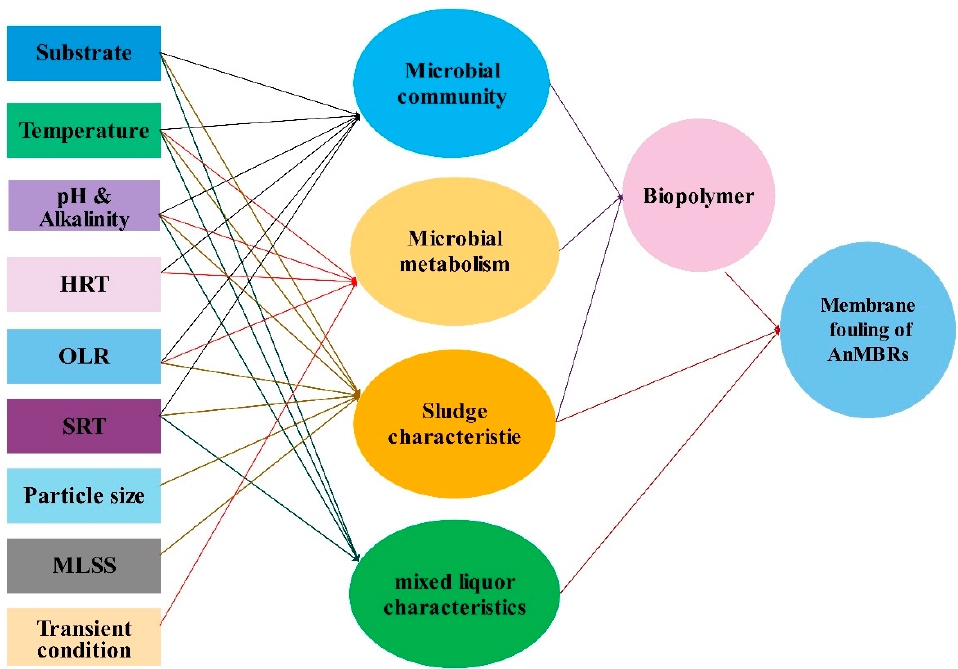
Figure 1. The operational factors a ff ecting membrane fouling in